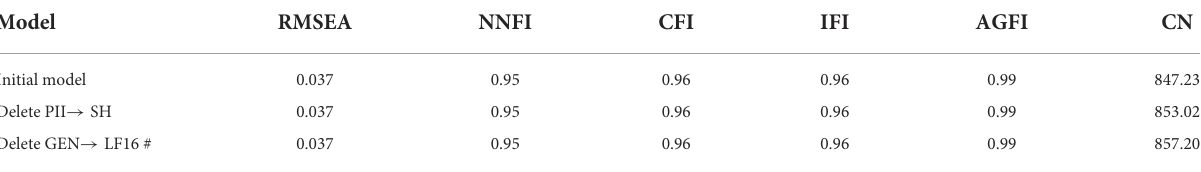
TABLE 2 Measures of goodness-of-fit for perceived the importance of the Internet, life satisfaction, and self-rated health model of the older people.